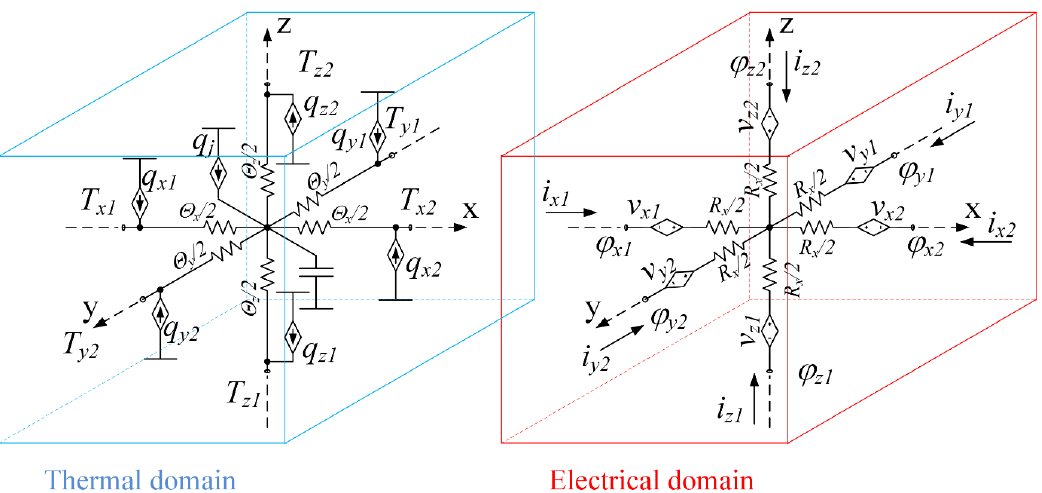
Figure 5. Thermal and electrical domains of the modified equivalent circuit for mutual simulation of electrical, thermal, and thermoelectric processes taking place in an elemental volume.